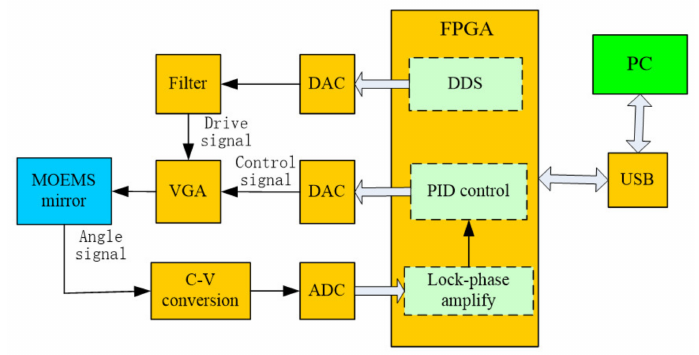
Figure 3. Structure block diagram of the drive and control system.